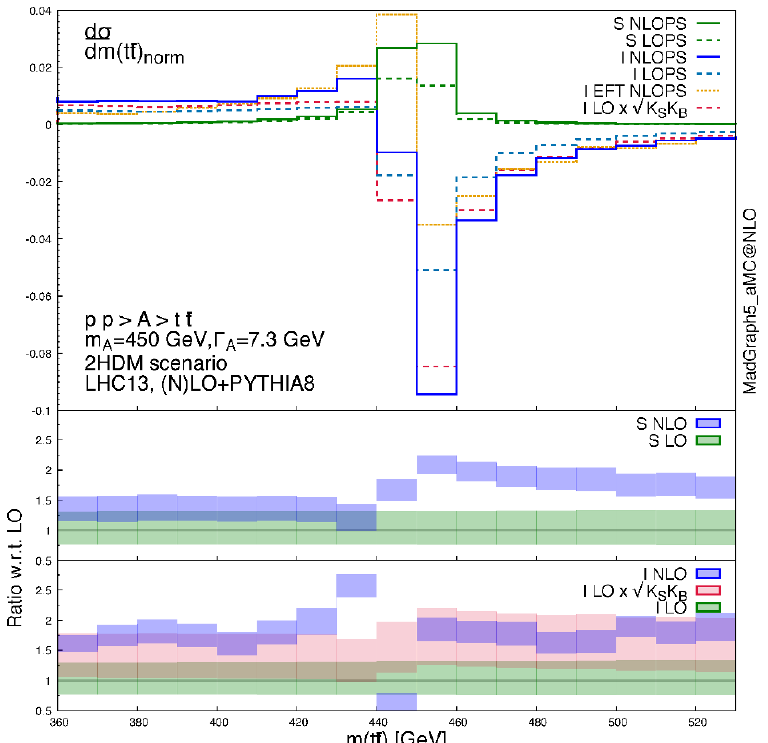
Figure 16 . Signal and interference lineshapes at (N)LO matched with PS for LHC 13 TeV. Re- sults are normalised to the SM fNLO lineshape. Lower panels show the K-factors and the scale uncertainties of signal and interference